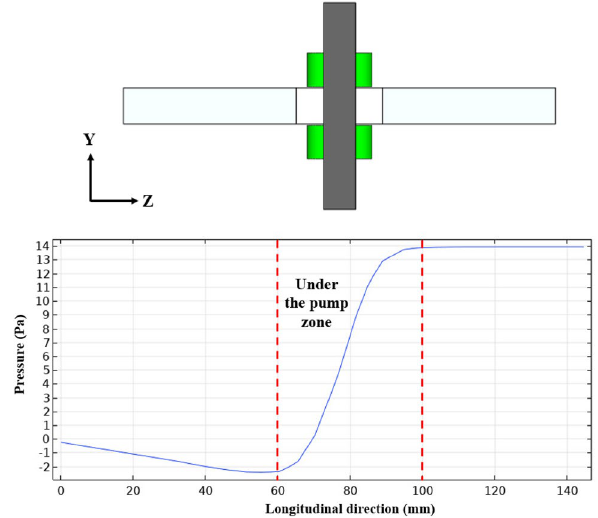
Fig. 9 The magnetic field profiles and lines once the middle coil was active